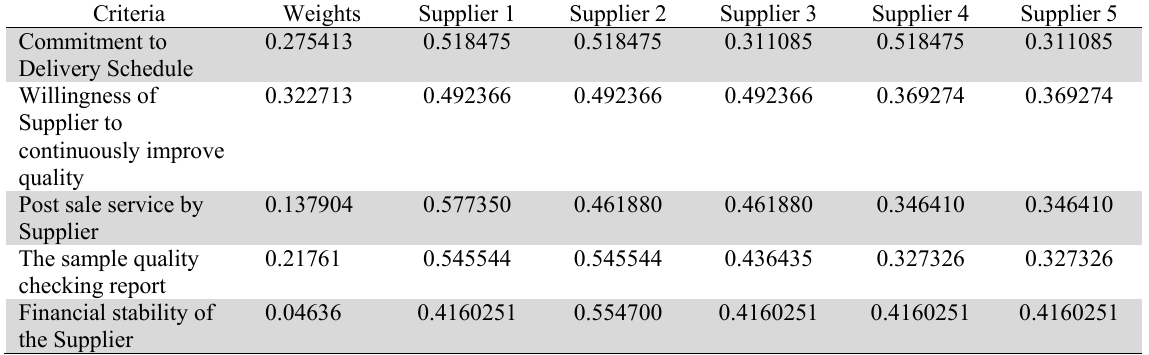
Multiplying criteria weight to each rating in the standardized decision matrix Criteria